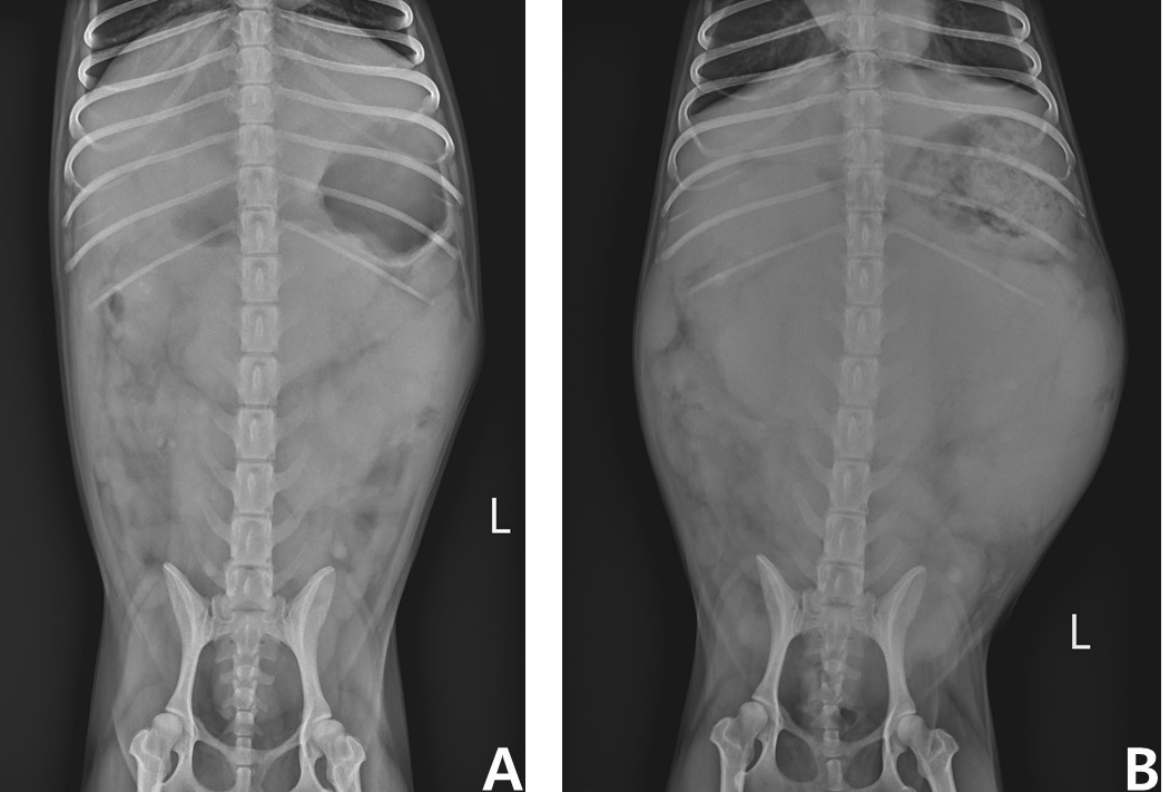
Figure 5. Ventrodorsal abdominal radiographs at the first and final visits (74 days). ( A ) First visit. ( B ) Final visit. Note the significant difference in abdomen size between A and B due to the enlarged spleen.